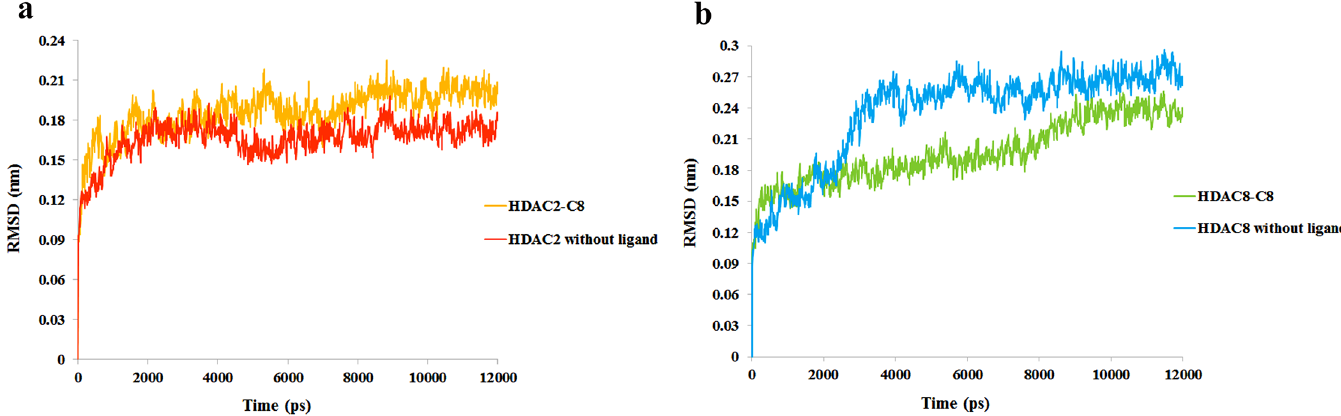
Fig 7. RMSD plot for 12 ns MD simulation. (a) RMSD plot for HDAC2-C8 complex (yellow) and HDAC2 without ligand (red). (b) RMSD plot for HDAC8-C8 complex (green) and HDAC8 without ligand (blue).